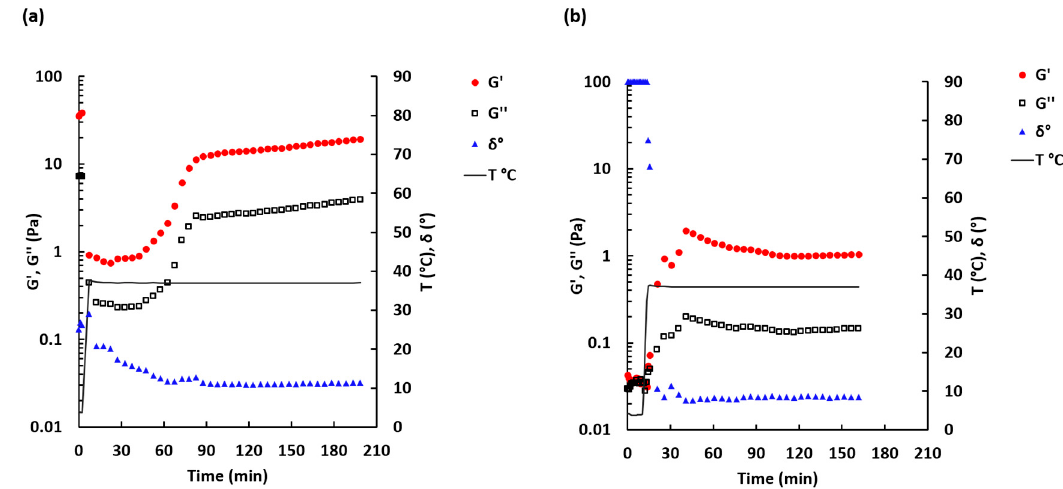
Figure 2. Sol-gel transition curve for 30 mg/mL DDB ( a ) and 1.5 mg/mL Matrigel ( b ) samples. Temperature was ramped from 4 to 37 °C (secondary scale). Oscillation frequency 0.5 Hz, shear strain 0.005. Mean n = 2–3.